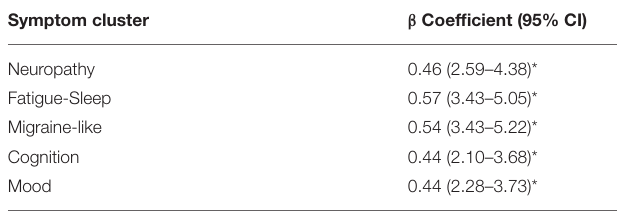
TABLE 1 | Symptom severity and impairment scores. TABLE 2 | Associations between symptom severity and global disability